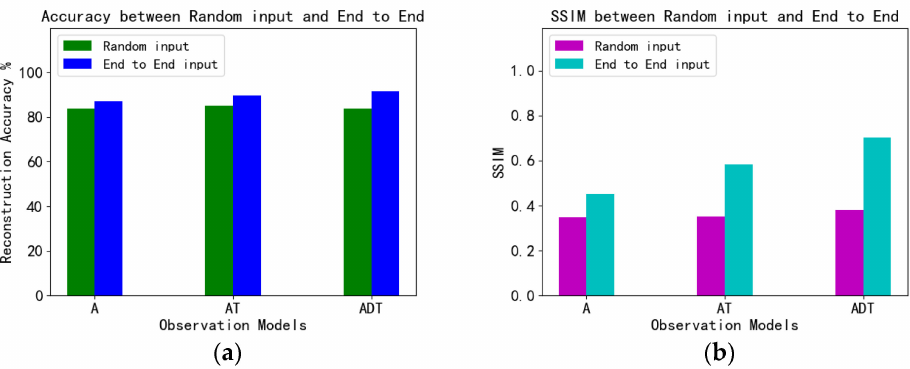
Figure 4. (Comparison of reconstruction accuracy ( a ) and SSIM ( b ) between random input and end-to-end.